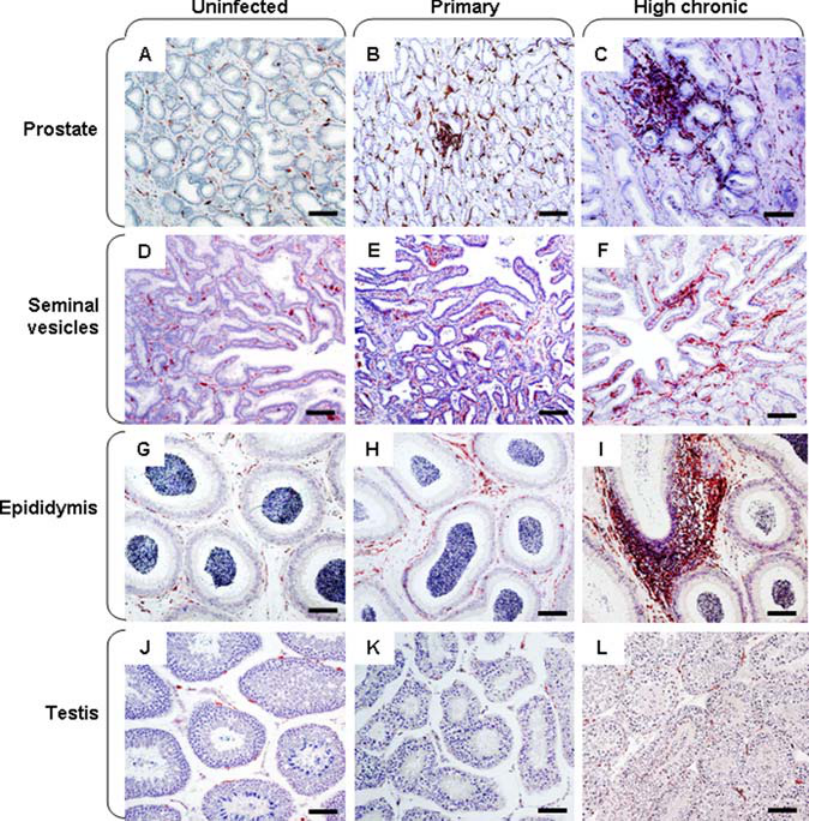
Figure 6. Immune activation in the male genital organs. Immunohistochemical detection of HLA-DR + cells in the prostate (A–C), seminal vesicle (D–F), epididymis (G–I) and testis (J–L) of uninfected (A, D, G, J), primary-infected (B, E, H, K) or high chronic macaques (C, F, I, L). Scale bars=100 m m.